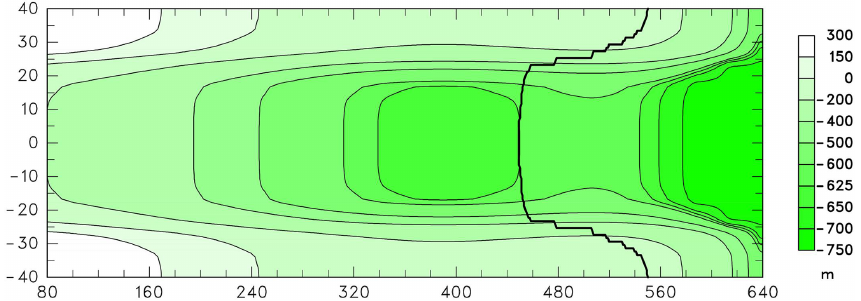
Figure 2. Bedrock topography used in the MISMIP + experiments (Cornford et al., 2020). Also shown is the “control” grounding line after spin-up at year 0 (thick black line). Axis scales are in km. The first 80km of the channel is not shown. Note the nearly factor of 3 stretching of the channel width relative to the length.